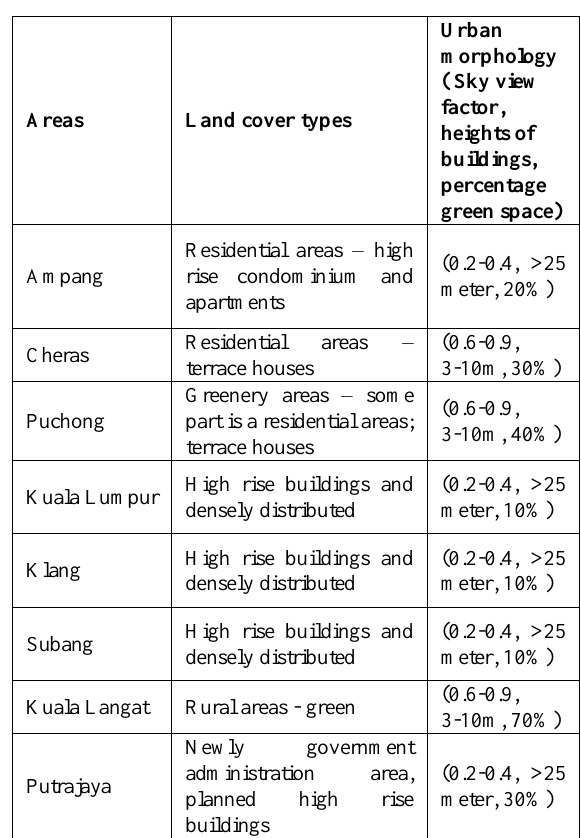
and urban morphology. A spatial analysis was performed to finalise the location of the areas by delineating a polygon on top of the proposed samples. Each polygon was reviewed to ensure